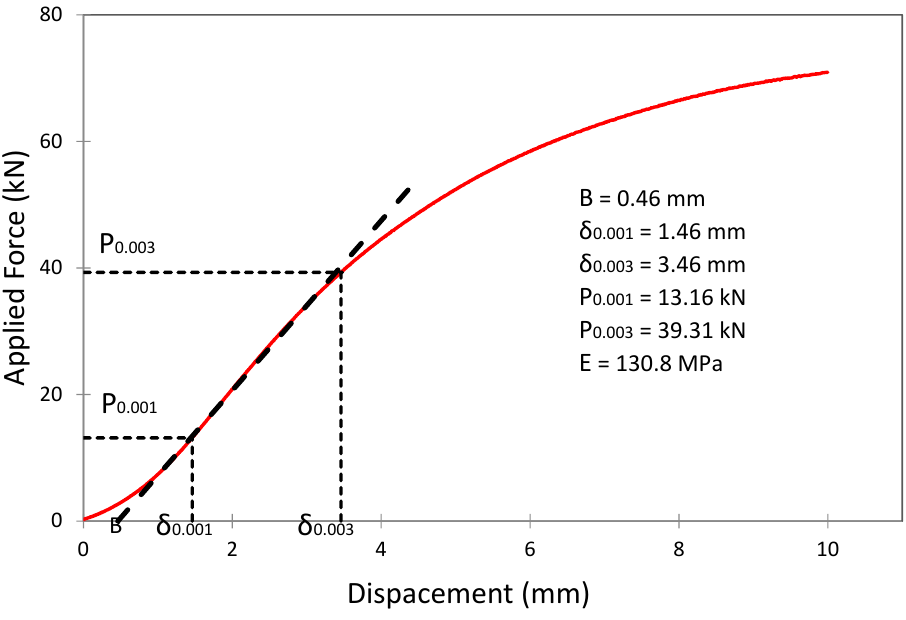
Figure 7. Description of flatwise compressive experiments calculation.